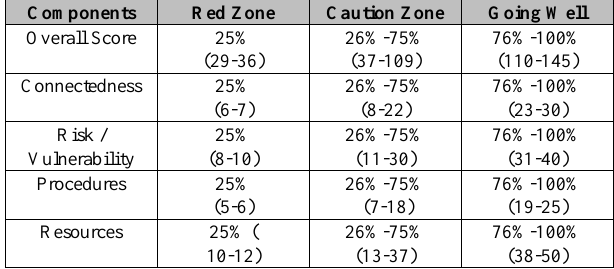
Disaster Resilience